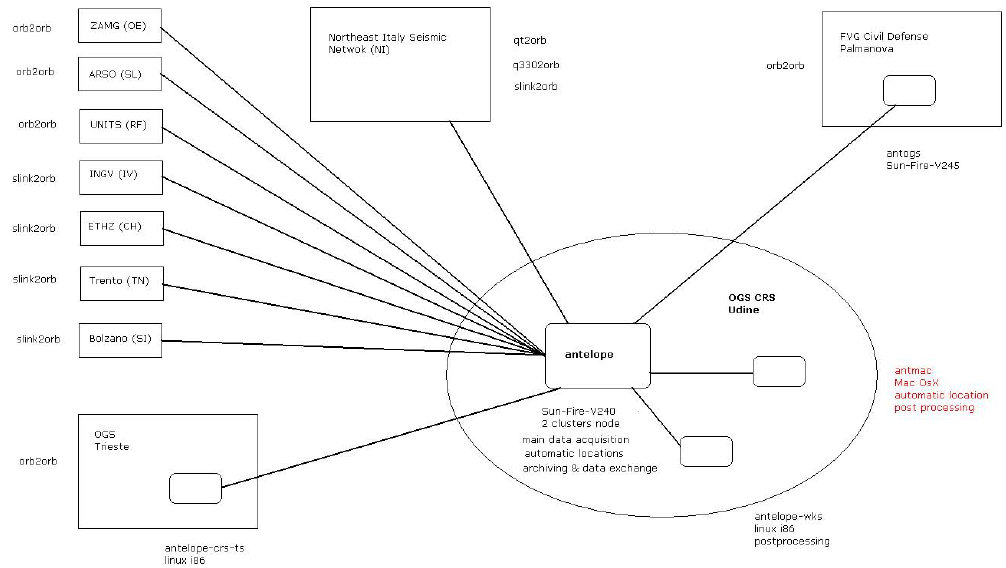
Fig. 2. Schematic of Antelope configuration at